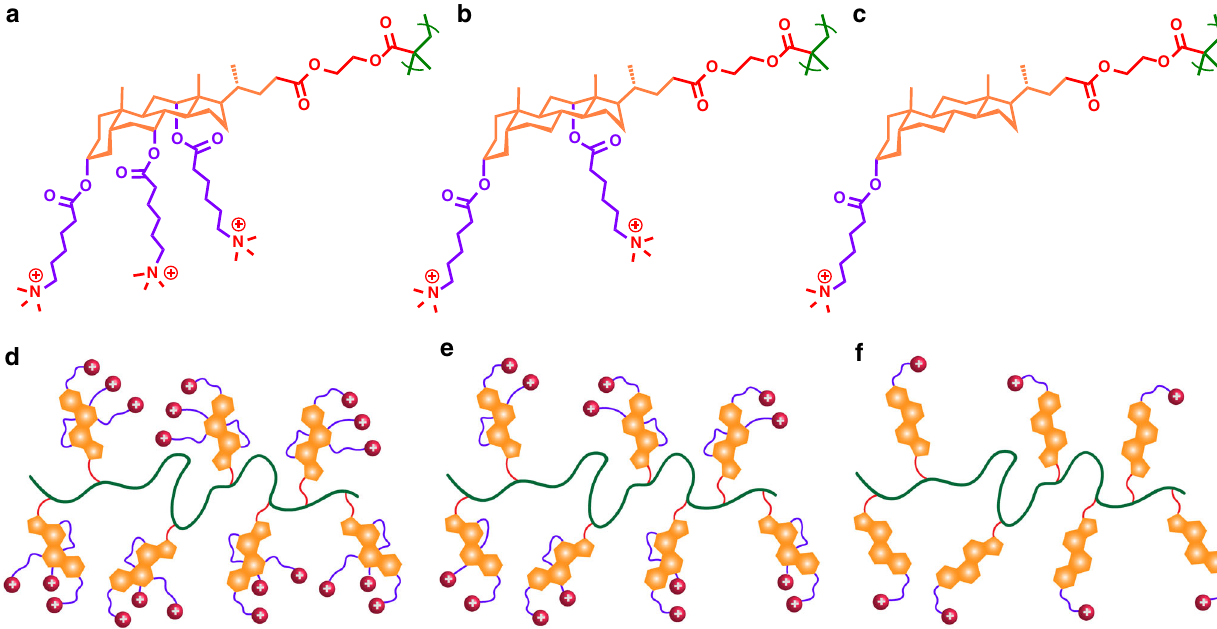
Fig. 4 Multicyclic natural product-based cationic polymer structures and their illustration. a , d CA polymer, b , e DCA polymer, c , f LCA